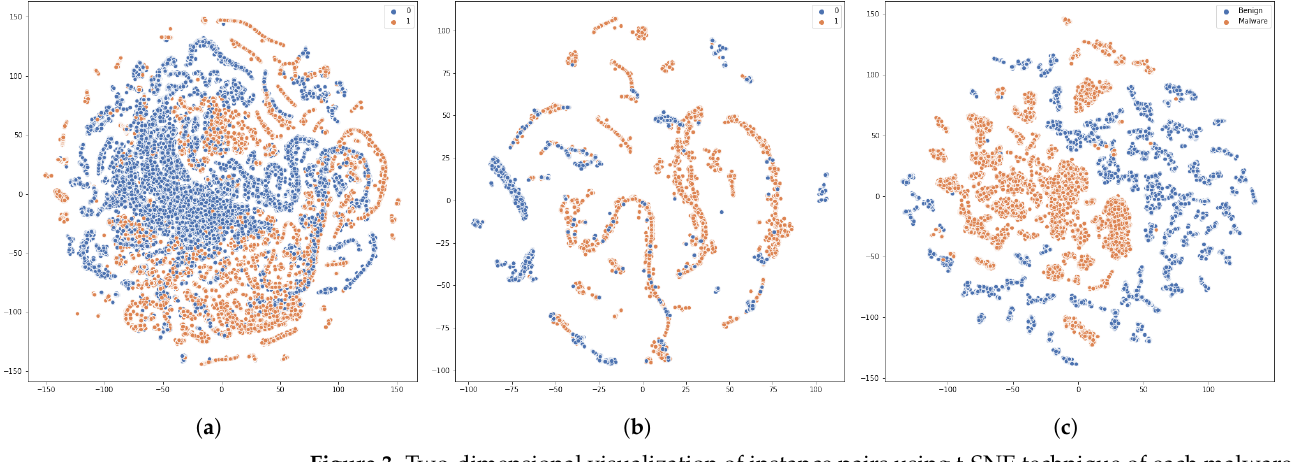
Figure 3. Two-dimensional visualization of instance pairs using t-SNE technique of each malware dataset: ( a ) BODMAS, ( b ) Kaggle, and ( c )